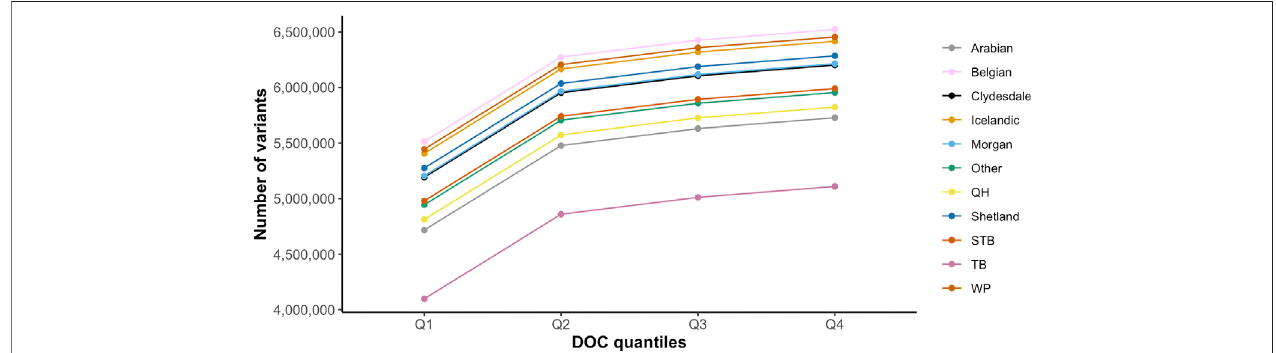
FIGURE1| Distributionoftheaveragenumberofvariantsidenti fi edforeachbreedbyDOCquantiles(Q1 (cid:1) 1.43 – 7.14X,Q2 (cid:1) 7.15 – 9.16X,Q3 (cid:1) 9.17 – 14.6X,Q4 (cid:1) 14.7 – 46.7 X). The colored lines represent the 10 target horse breeds [Arabian, Belgian, Clydesdale, Icelandic horse, Morgan horse, Quarter Horse (QH), Shetland, Standardbred (STB), Thoroughbred (TB), and Welsh Pony (WP)] and the remaining horse breeds